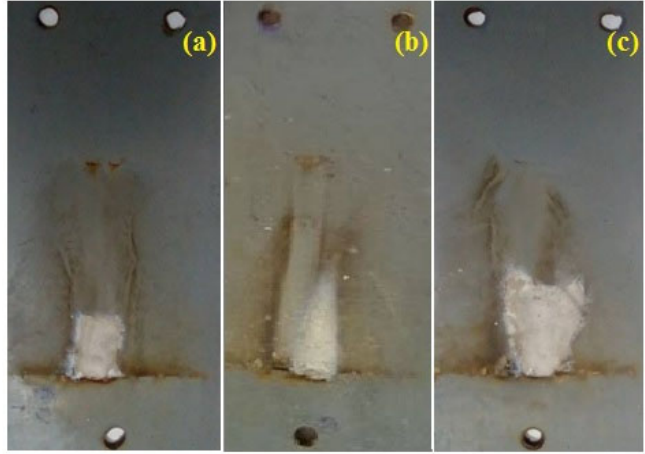
Figure 7. Images of the highly eroded and tracked samples: ( a ) Fresh, ( b ) thermal-aged, ( c ) water-aged.